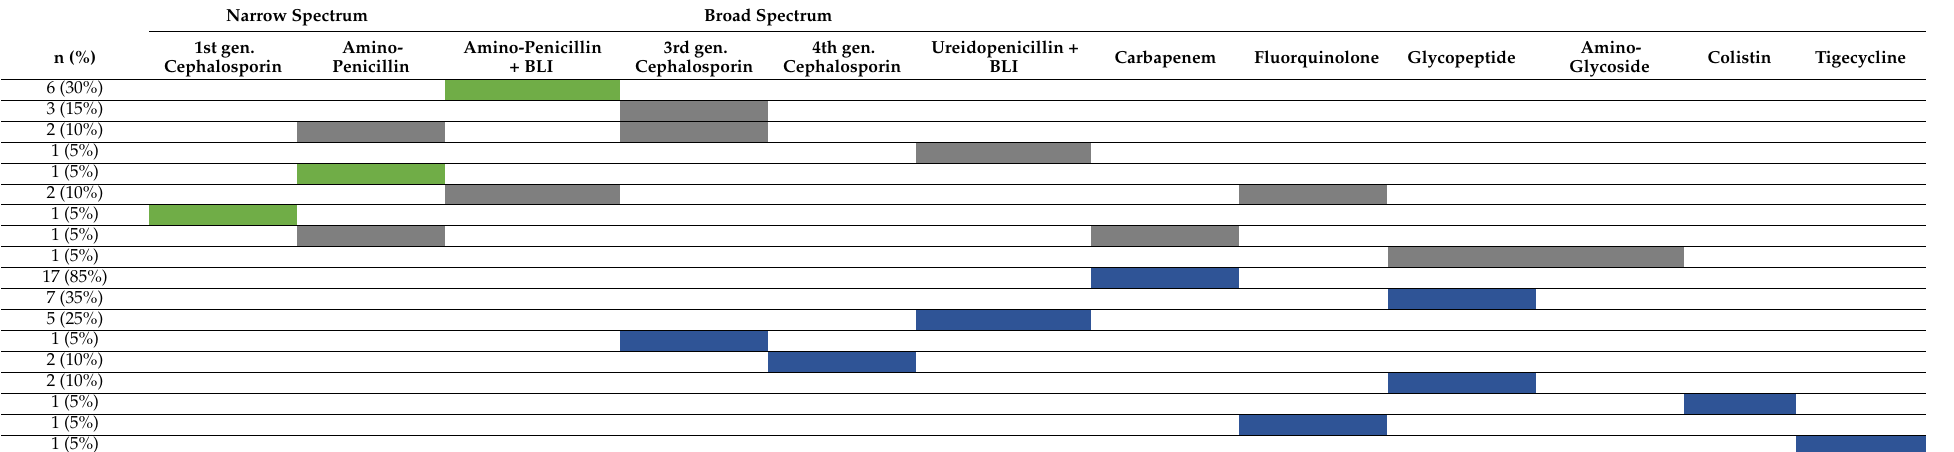
Table 2. Antibiotics for perioperative prophylaxis and for escalation